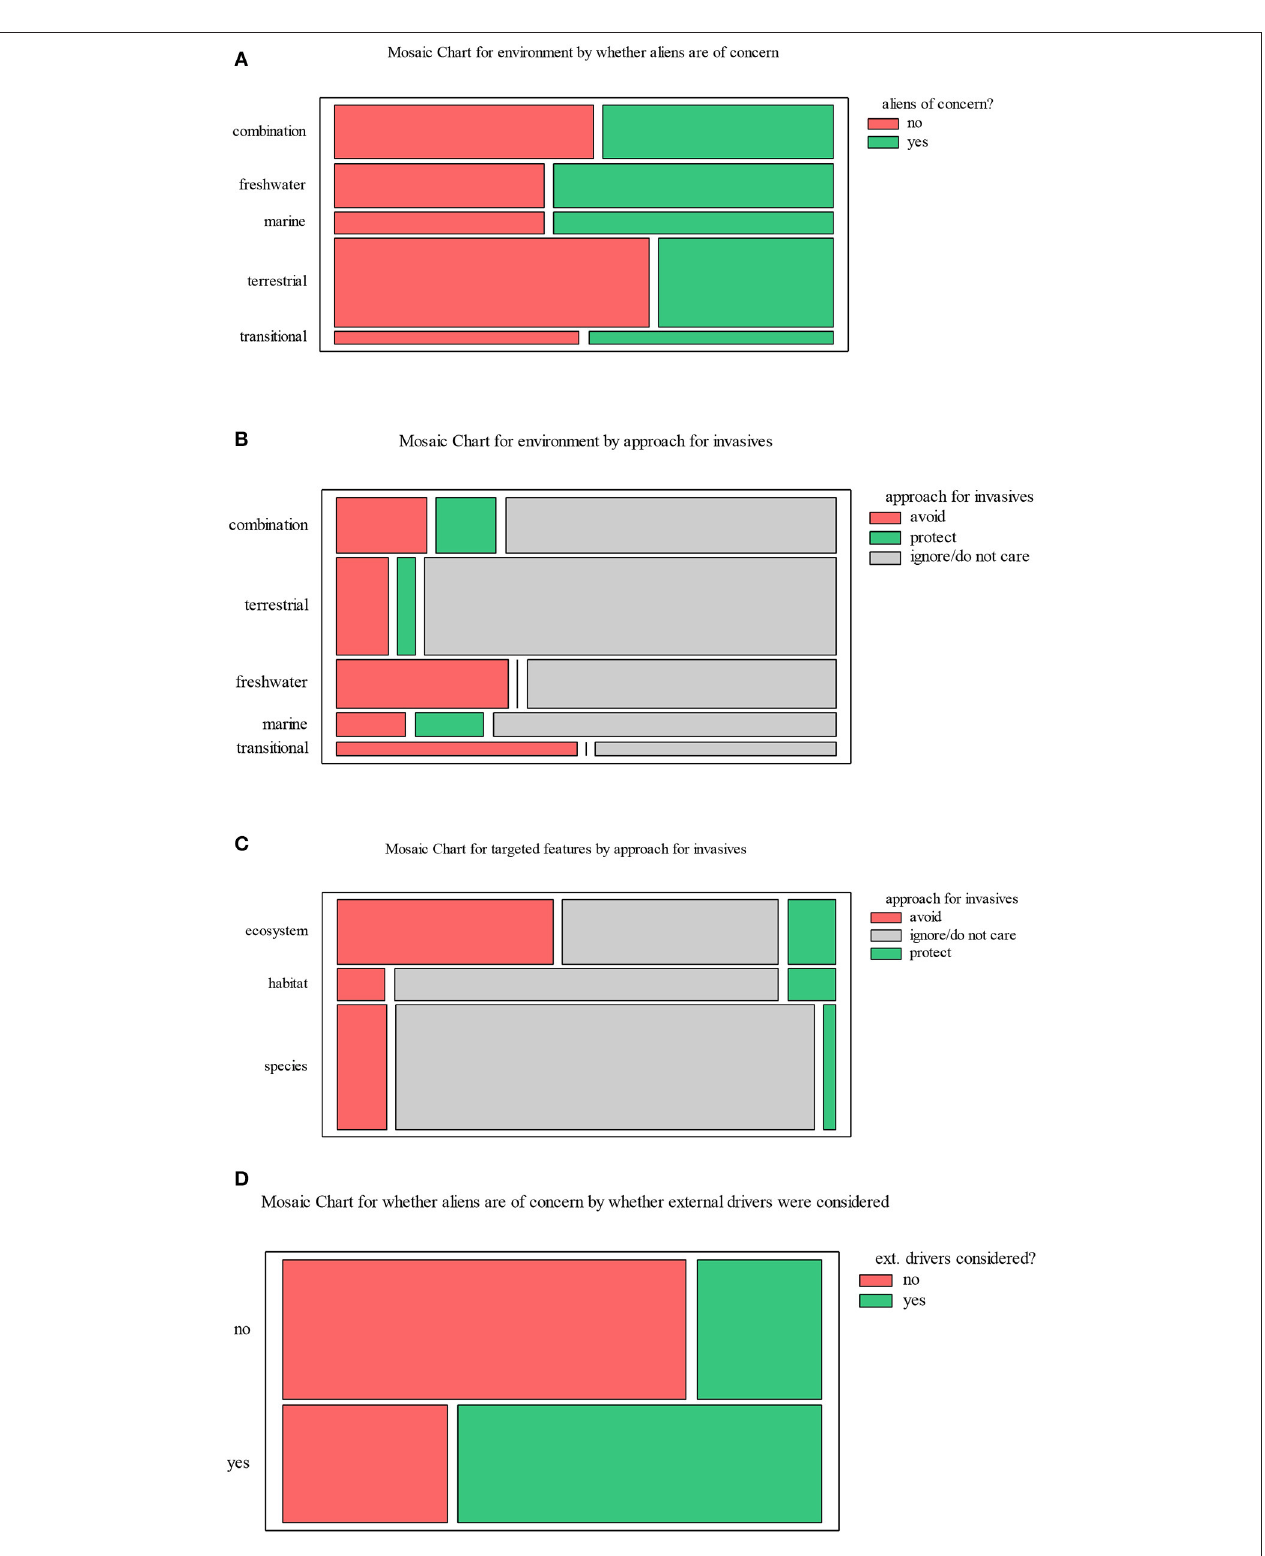
FIGURE 3 | Mosaic charts showing (A) if alien species were considered of concern in the various realms, (B) which approach (“protect,” “avoid,” or “ignore”) was adopted in conservation plans concerning alien species by environment, (C) which approach was adopted in conservation plans concerning alien species in relation to the targeted features, and (D) if other drivers impacting conservation efforts were taken into account in addition to biological invasions.